Question: What kind of plot is shown here?
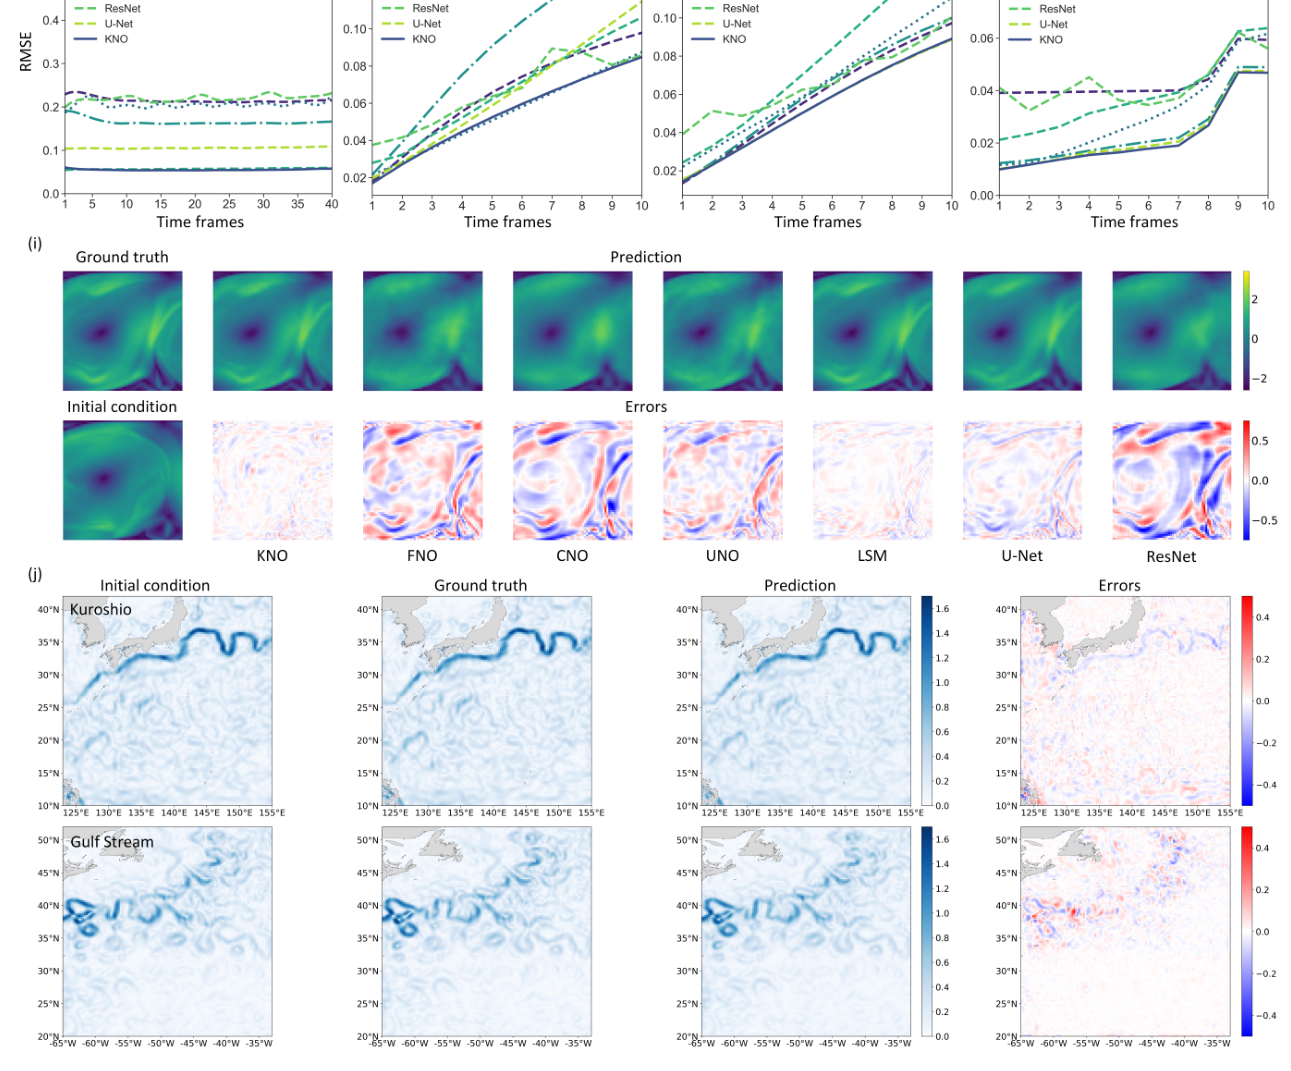
Answer: bar